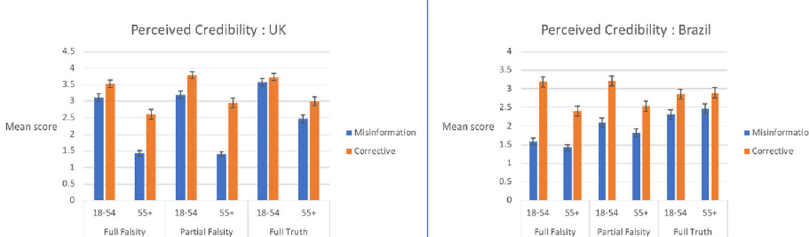
Fig. 4 Perceived credibility. Mean perceived credibility scores across misinformation types and exposures in the UK and Brazil.